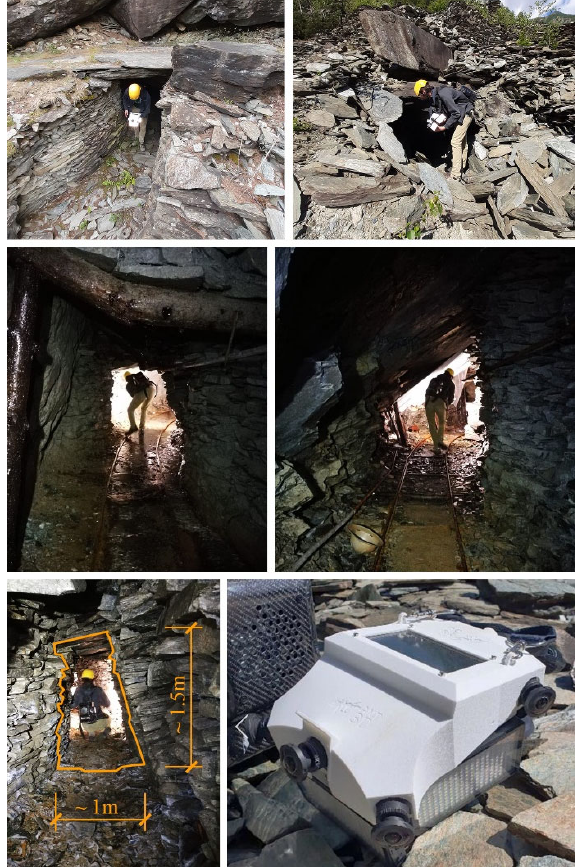
Figure 2. Photos of the entrance (top) and inside areas (middle) of the tunnels during the 3D acquisition carried out using the Ant3D multi-camera system (bottom